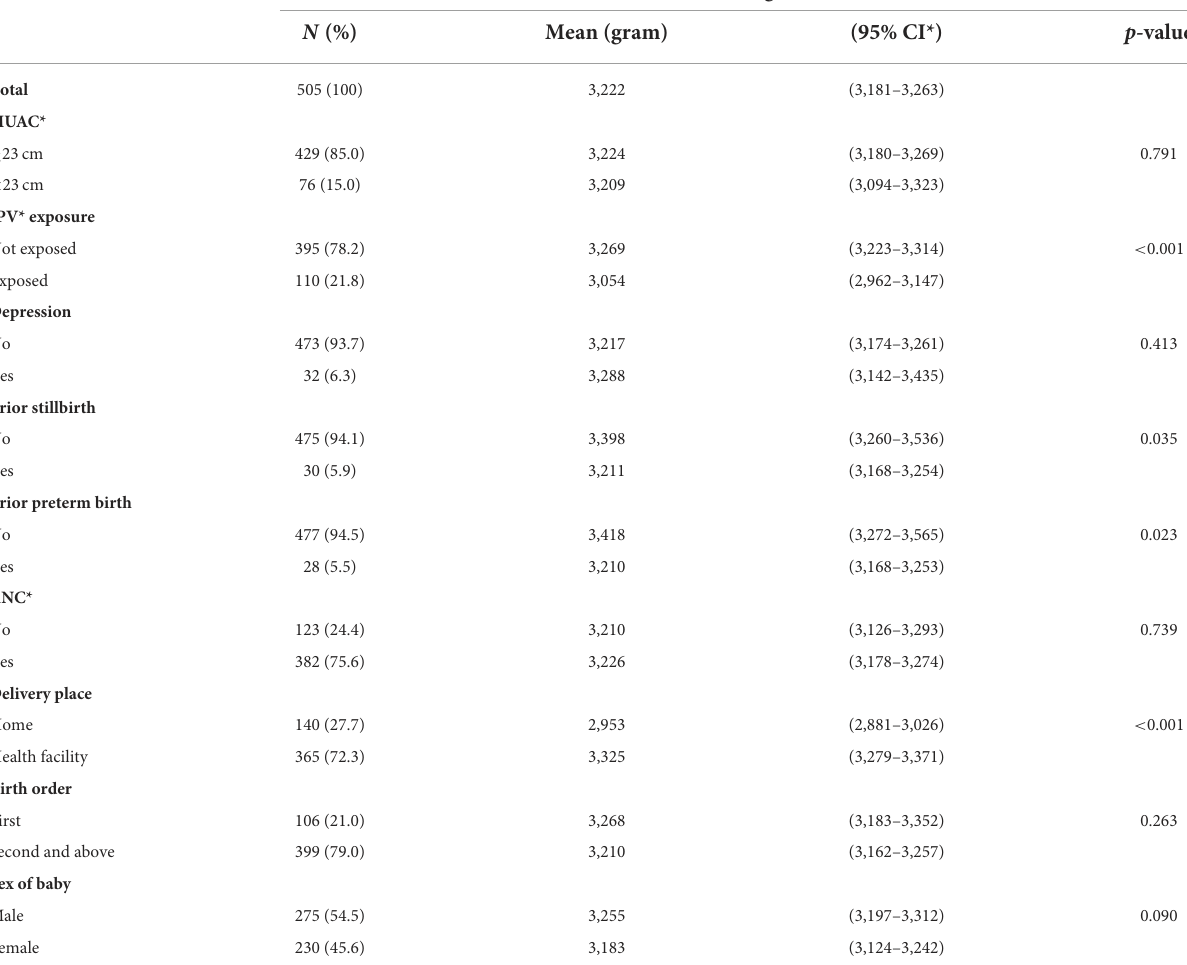
TABLE 2b Mean birth weight of babies by clinical characteristics of their mothers in Wondo Genet district, Ethiopia, 2017.